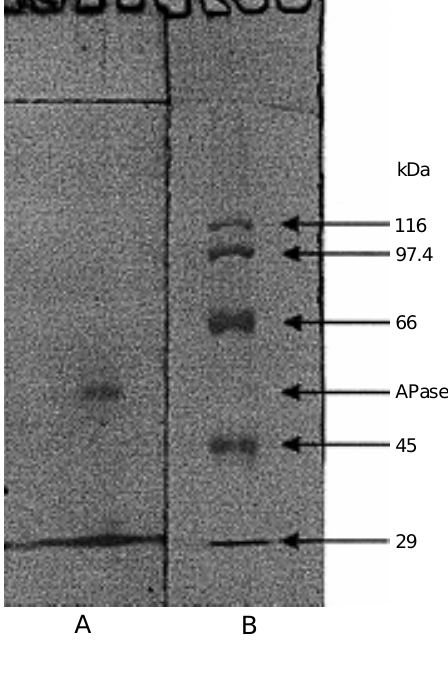
Figure 4 - Effect of various com- pounds on the p -nitrophenyl phosphatase activity, pH 8.9, of purified constitutive alkaline phosphatase synthesized by strain 74A of N. crassa . A-G rep- resent 1 mM Mg 2+ , Zn 2+ , Cu 2+ , F - , Be 2+ , EDTA and histidine, re- spectively. H and I represent 10 mM histidine and control, re- spectively.